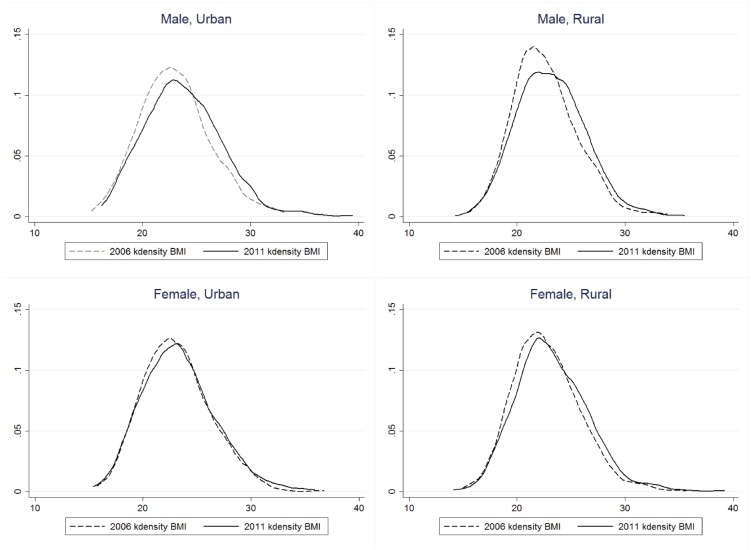
BMI density curves in 2006 and 2011.